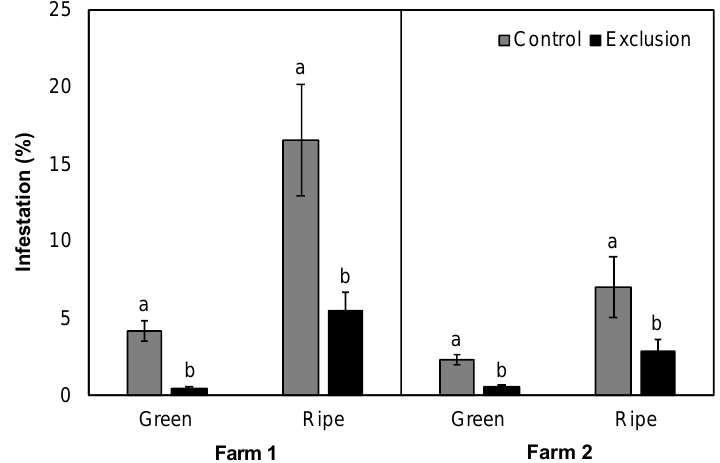
Figure 2. Percent (mean ± SE) CBB infestation in green and ripe coffee fruit sampled from control (un-netted) and exclusion plots across two coffee farms on Hawai’i Island. Lowercase letters represent significant differences in the means.